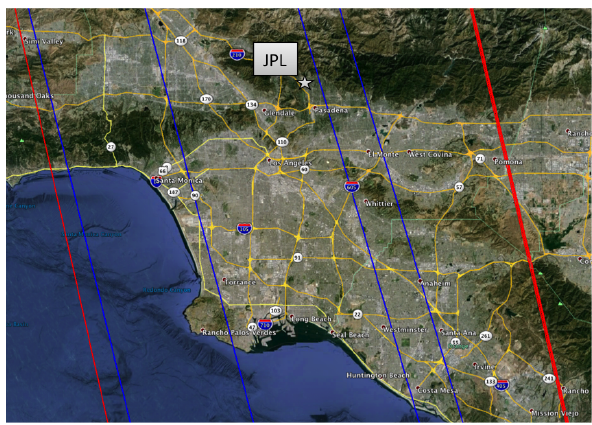
Fig. 11. OCO-2 Orbit track simulations for Nadir (red) and Glint (blue), in each season, in the larger Los Angeles area. The nominal target tracks are shown here. These may change slightly, depend- ing on the exact orbit achieved. Nadir repeat cycles of 16-days are close repeats but Glint viewing orbits shift during the year owing to changes in the sun-earth geometry.